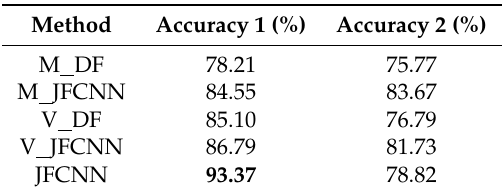
Table 4. Classification accuracies (%) of comparisons between the proposed methods and the end-to-end based methods.